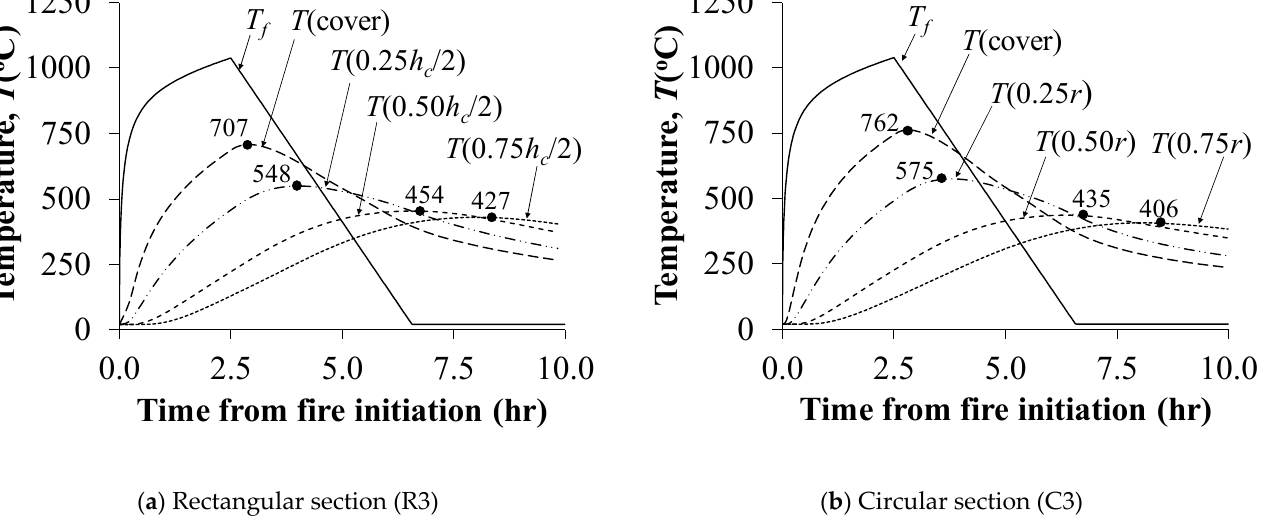
Figure 6. Temperature variation with time at different points along the cross-section.